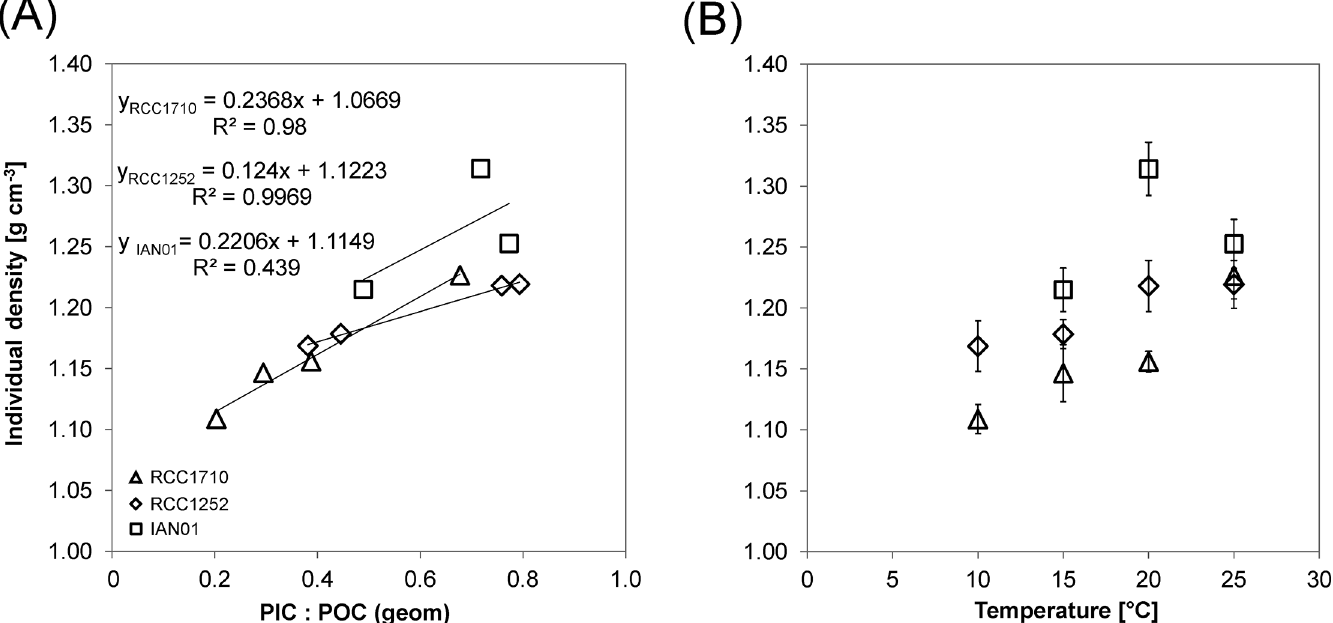
Fig 2. Individual cell density versus the geometrically derived ratio between the particulate inorganic carbon and the particulate organic carbon (A) and versus temperature (B). RCC1710 (triangle symbols), RCC1252 (diamond symbols), and IAN01 (square symbols). Linear trend lines, corresponding equations, and r-squared values are shown in Fig